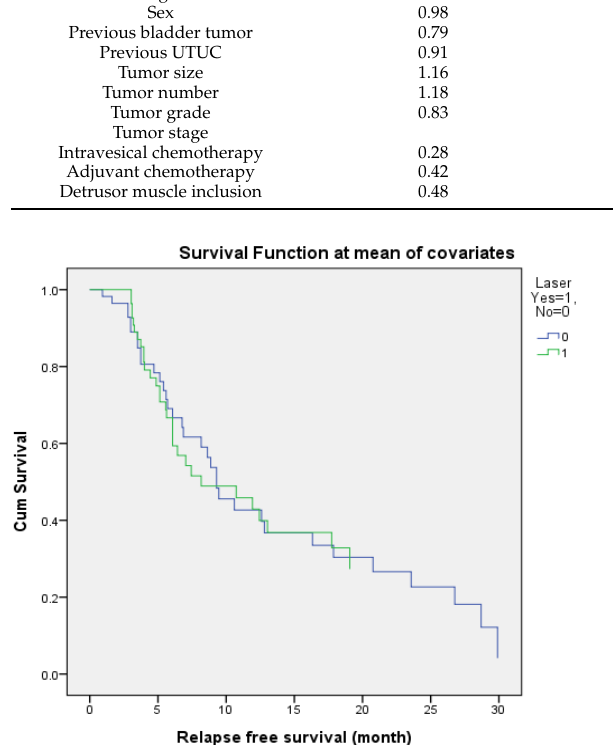
Figure 1. Adjusted Kaplan–Meier estimated recurrence-free survival between laser en-bloc resection of bladder tumor (LERBT) (green) and conventional transurethral resection of bladder tumor (CTURBT) (blue). (Adjusted variables: age, sex, previous bladder tumor, previous upper urinary tract urothelial carcinoma (UTUC), tumor size, tumor number, tumor grade, tumor stage, intravesical chemotherapy, adjuvant chemotherapy, and detrusor muscle inclusion).